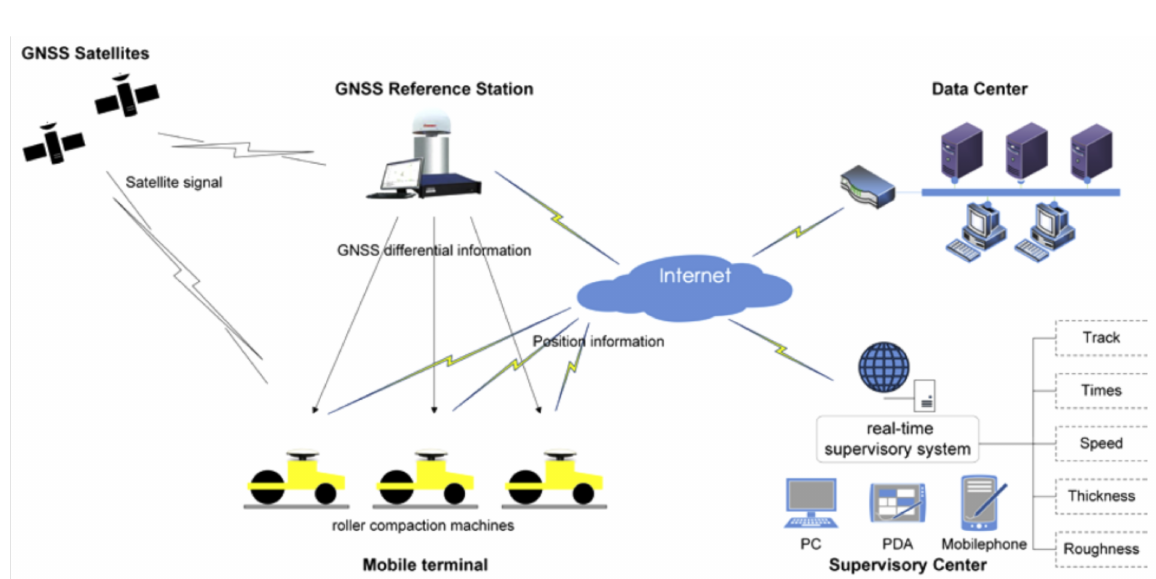
Figure 7. The GNSS real-time compaction quality supervisory system (reprinted with permission from Reference [105], copyright Elsevier,